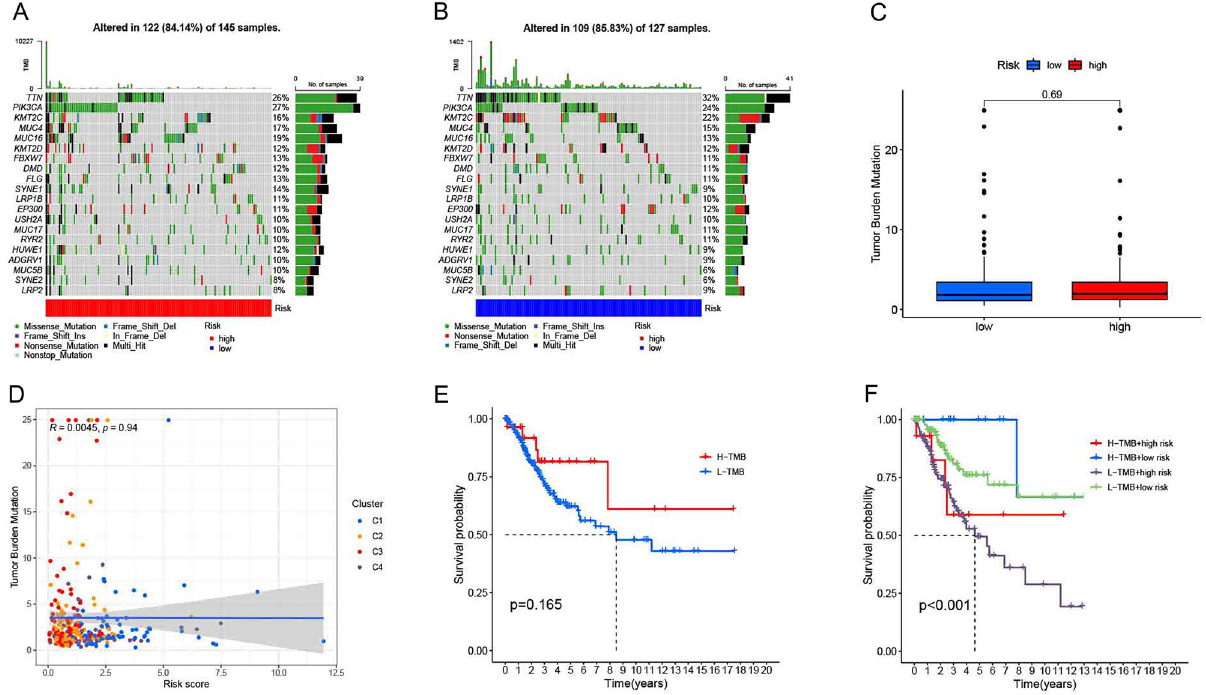
Figure 13. Correlation analysis among the TMB groups and two risk subgroups. ( A – B ) Distribution of the top 20 genes of TMB in the high and low risk groups; ( C ) Distribution of TMB in the high and low risk groups; ( D ) Correlation between the TMB and risk scores; ( E – F ) Relationship of overall survival in CESC patients among the TMB subgroups, high-risk and low-risk groups.